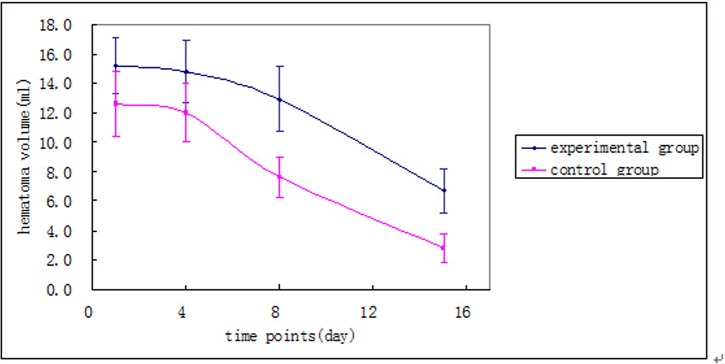
Trends in hematoma volume at admission, and on the 4th, 8th, and 15th day (or discharge).